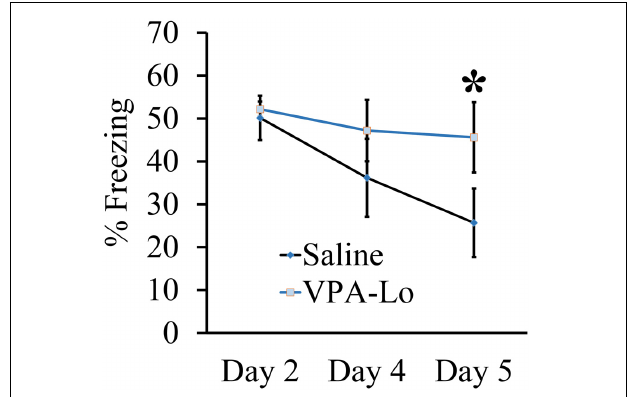
FIGURE 2 | Progeny from VPA-Lo exposed dams exhibit reduced fear extinction to a conditioned auditory cue. Progeny from VPA-Lo and saline exposed dams were auditory fear conditioned and LTM/extinction learning was assessed on days 2, 4, and 5 post fear conditioning (Saline = 12, VPA-Lo = 12). Bars represent the mean ± s.e.m. ( ∗ p < 0 . 05 ).